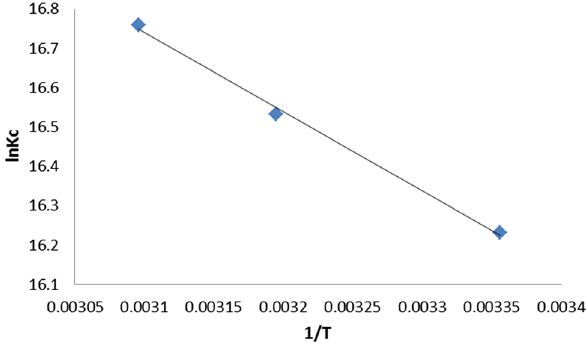
Fig. 10 Plot of ln Kc versus 1/ T for the estimation of thermodynamic